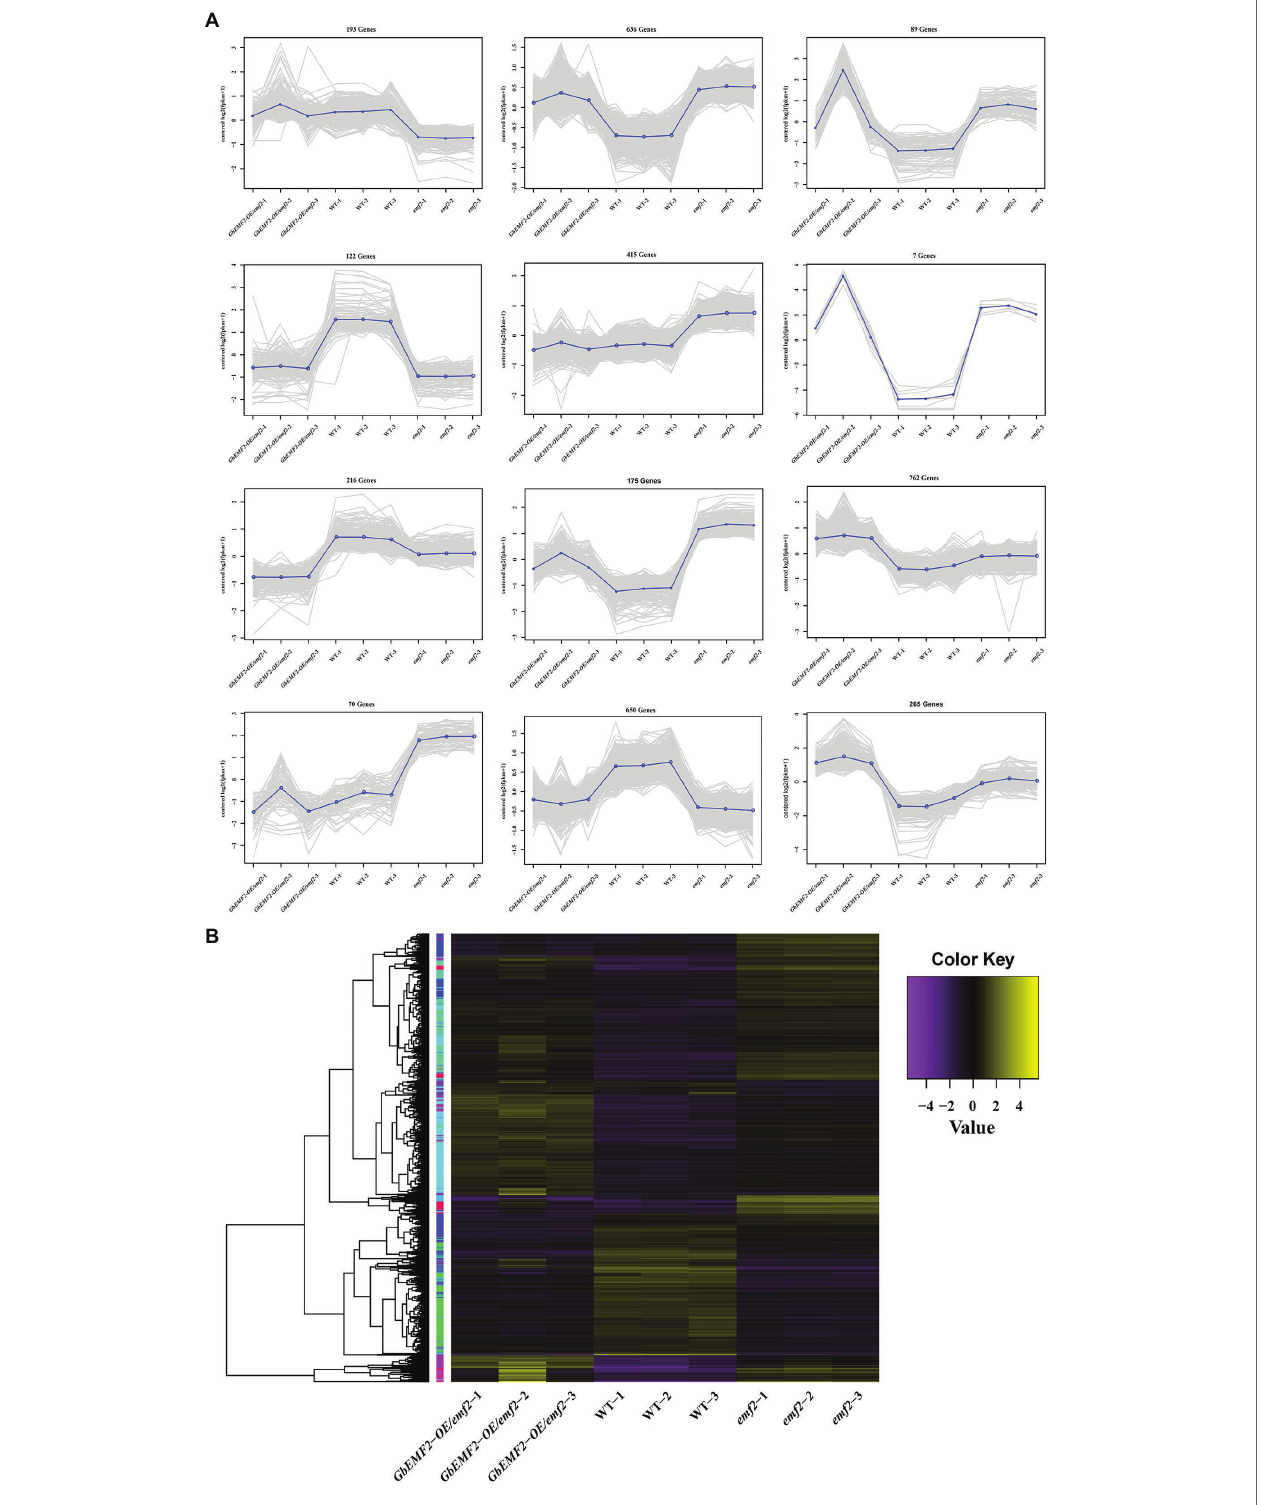
FIGURE 6 | Expression profiles of significant DEGs. (A) Clusters of DEGs were obtained by K-means. DEGs were divided into 12 subclasses. (B) Heat map for cluster analysis of DEGs by hierarchical cluster combined with K-means method. The change in the expression level is represented by the change in color; purple indicates a lower expression level, and yellow indicates a higher expression